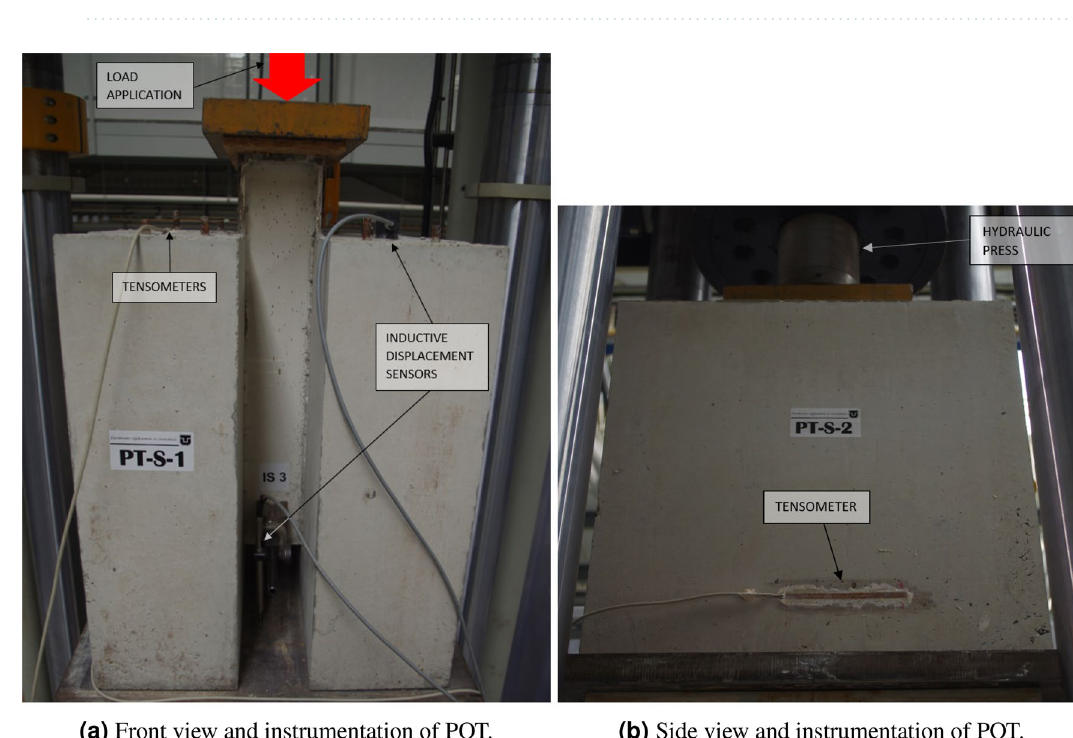
Figure 6. Experimental